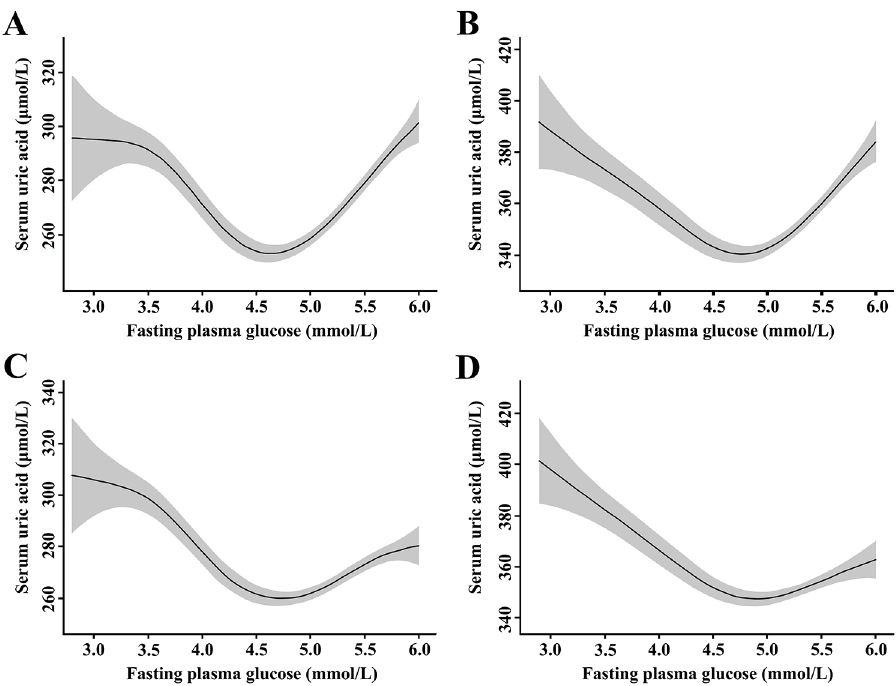
Fig 1. Nonlinear relationship between fasting plasma glucose and serum uric acid. No adjustmentin women (A) and in men (B); adjustmentfor age, body mass index, systolic body pressure, diastolicblood pressure, total cholesterol, triglycerides, drinkingstatus, smoking status, estimated glomerular filtration rate and serum insulinin women (C) and in men (D). The shaded areas indicate 95% confidenceintervals.